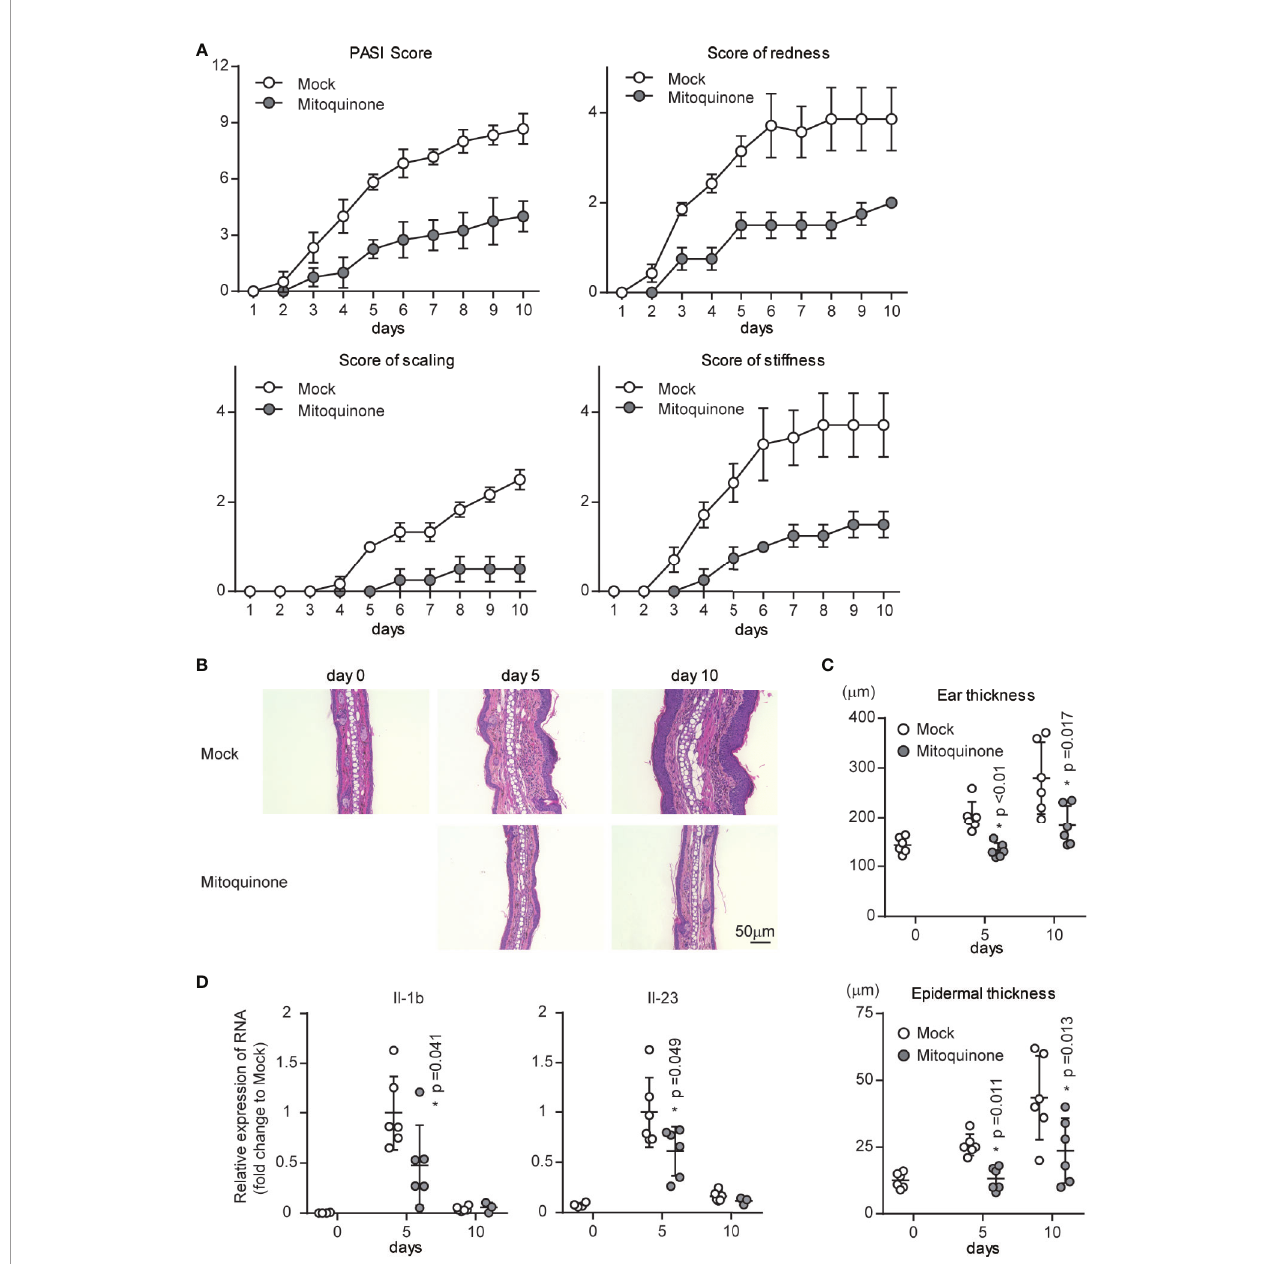
FIGURE 6 | Effects of a mitochondrial ROS inhibitor on psoriatic in fl ammation in vivo . WT mice were topically treated with IMQ for 9 consecutive days and received either mitoquinone or mock treatment every 2-3 days by intraperitoneal injection, beginning on day 0. (A) Cumulative Psoriasis Area Severity Index (PASI) scores were calculated based on the individual scores for redness, scaling, and stiffness daily until 9 days after IMQ application. Data are shown as means ± SDs (n = 4 – 6). (B, C) Microscopy of cross-sections of mouse ears stained with hematoxylin and eosin (B) . Changes in ear ( C upper) and epidermal ( C lower) thickness over time. Scale bars, 50 µm. (D) Real-time PCR analysis was performed to assess mRNA levels in IMQ-treated mouse ears on days 5 and 10 (n ≥ 3). The results were normalized to 18S expression and are shown as means ± SDs. *p < 0.05 versus mock treatment. Data are representative of three independent